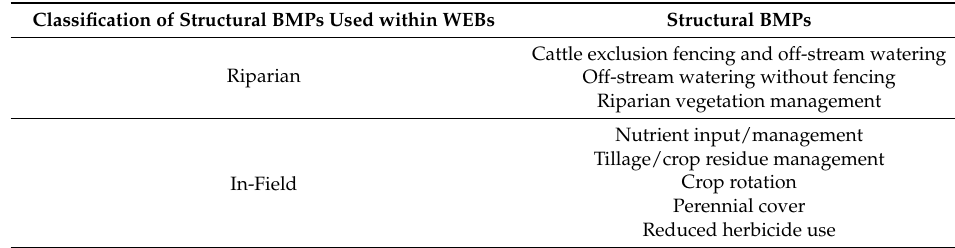
Table 2. Types of structural BMPs used within WEBs